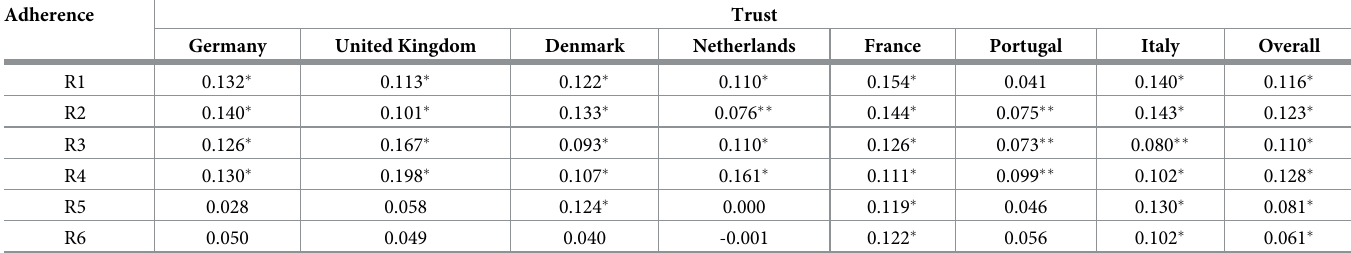
Table 5. Correlations between level of trust and level of adherence.